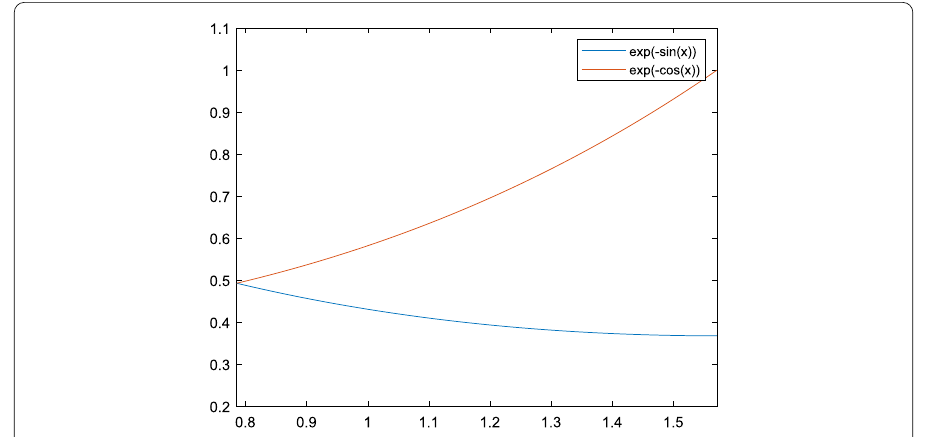
Figure 1 Illustration of Example 3.10: the function f is the blue line and the function f is the red